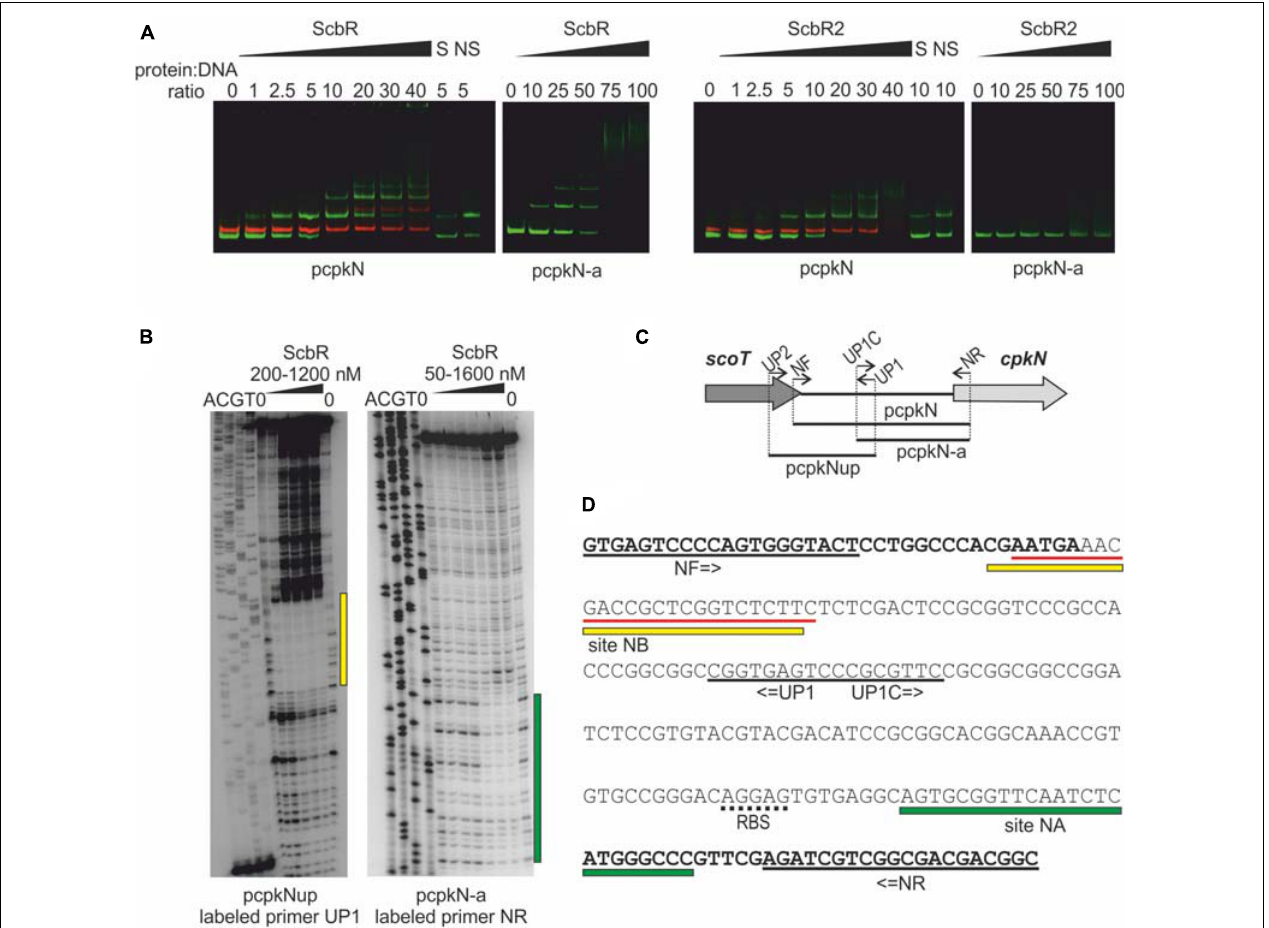
FIGURE 5 | Binding of His-tagged ScbR and ScbR2 proteins to cpkN promoter region. (A) Electrophoretic mobility shift assay. Green bands – IRDye 800 labeled fragments pcpkN and pcpkN-a, red bands – IRDye 700 labeled negative control fragment MYCO, S, 10-fold excess of unlabeled specific competitor DNA (pcpkN); NS, 10-fold excess of unlabeled non-specific competitor DNA (MYCO). (B) Protection of cpkN promoter region from digestion by ScbR protein (DNase I footprint). The amplified fragments and the radiolabeled primers are indicated below the lanes. Protected regions are marked with yellow and green bars. (C) Schematic representation of the location of primers and fragments used for EMSA and footprint experiments. (D) Nucleotide sequence of pcpkN fragment. Coding sequences of scoT and cpkN genes are in bold. Predicted ribosome binding site (RBS) is underlined with a dotted line. Primer sequences are underlined with black solid lines. Regions protected by ScbR protein from (C) are marked with yellow and green bars. Sequence recognized by ScbR2 reported by Li et al. (2015) is underlined with red